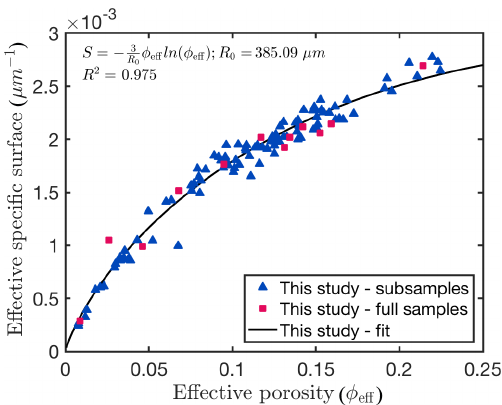
Figure 3. Effective specific surface as a function of effective poros- ity. Blue triangles represent subsample data from this study and red squares the effective specific surface of full samples. Full sample data points are plotted in order to show that in terms of effective specific surface subsamples represent full samples very well. The black curve represents the fitted curve according to Eq.